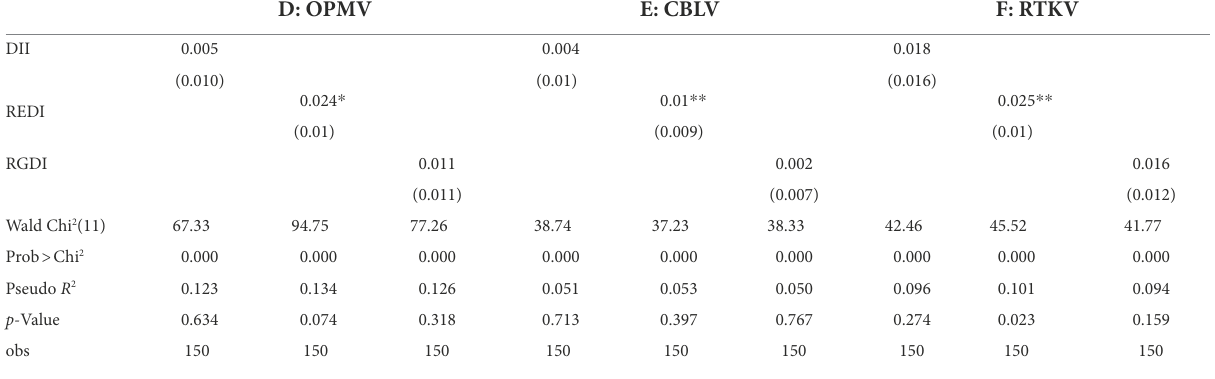
TABLE 5 Baseline regression results for digital economy and